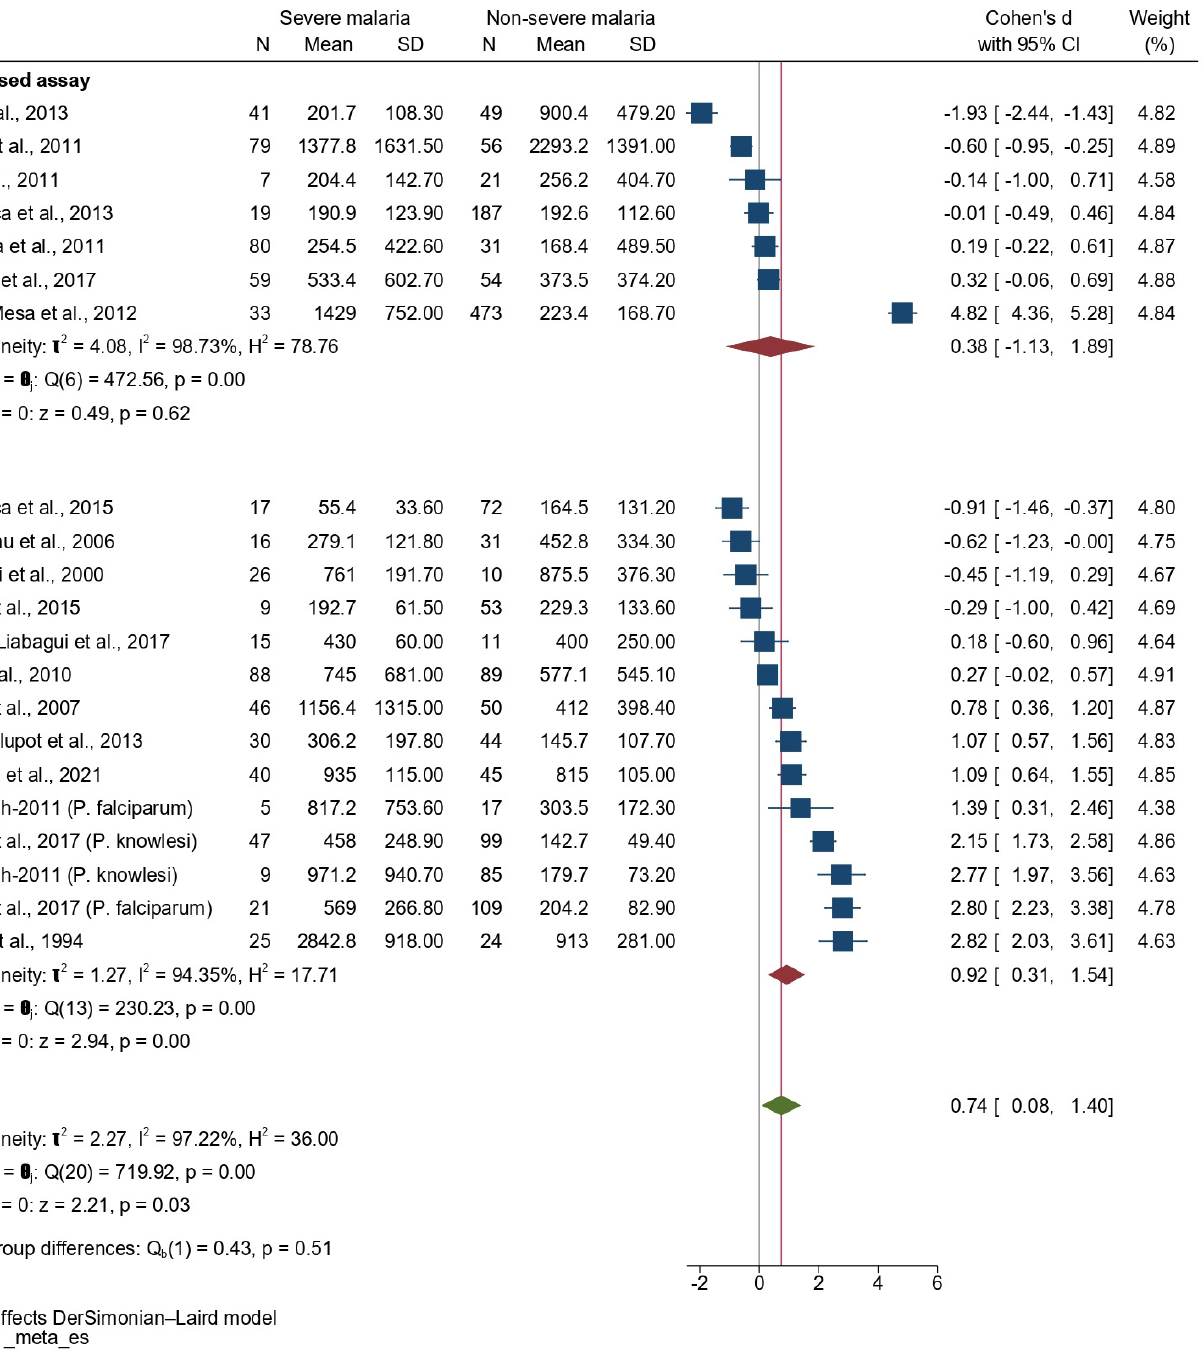
Figure 7. Forrest plot showing the SMDs of IL-10 levels between patients with severe malaria and patients with non-severe malaria stratified by methods used for IL-10 detection. Abbreviations: CI, confidence interval; SD, standard deviation. Symbols: blue square, point estimate (SMD of IL-10); green diamond, pooled effect estimate (pooled SMD of IL-10); red diamond, pooled effect estimate in each